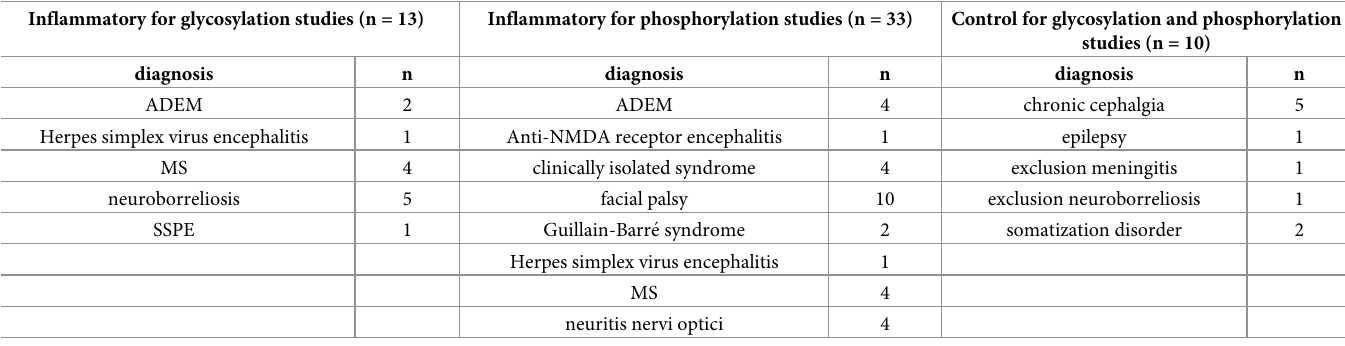
Table 4. Clinicial diagnoses of samples for glycosylation and phosphorylation studies. Inflammatory for glycosylation studies (n =